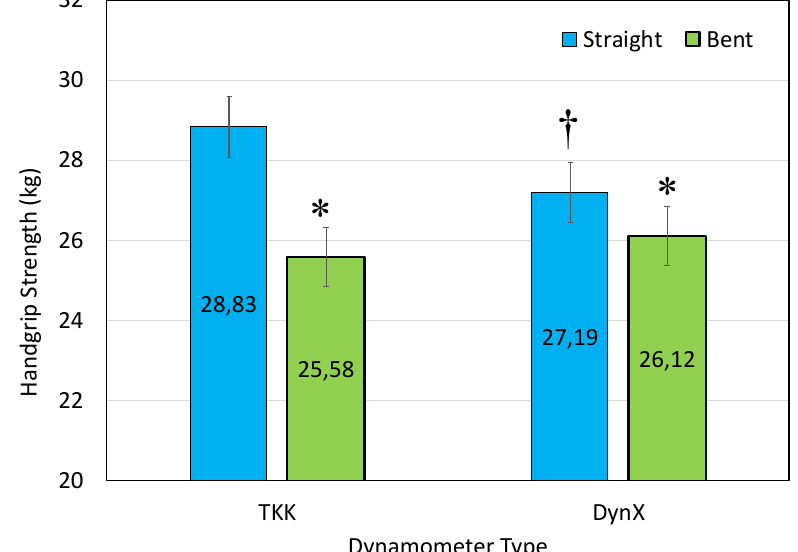
Figure 2. Comparison of handgrip strength measured with elbow at full extension (blue) and with elbow flexed at 90° (green) in children aged 6 to 11 years (n = 60). Sum of right and left hand scores is shown, and was used for analyses. Data are expressed as mean ± SE. * p < 0.001 vs elbow at full extension. † p < 0.001 vs TKK dynamometer with elbow at full